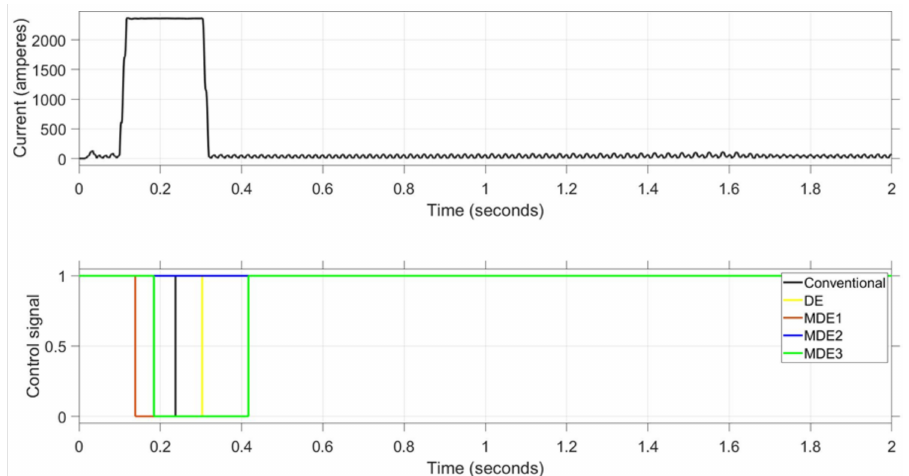
Figure 7. Fault clearance with conventional and optimized settings for a falling voltage profile mode.